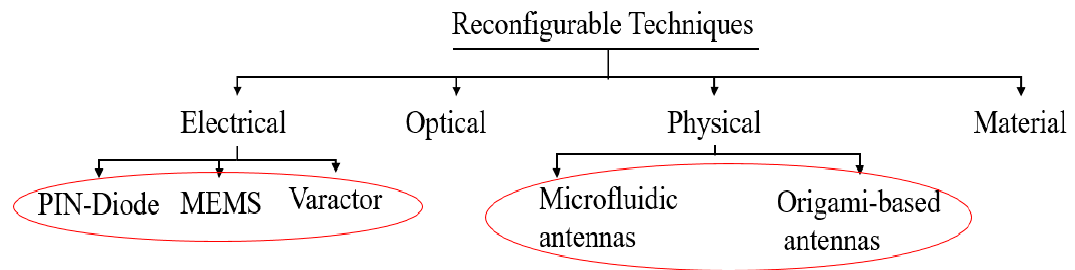
Figure 1. Categorization of reconfiguration techniques for all types of antennas.